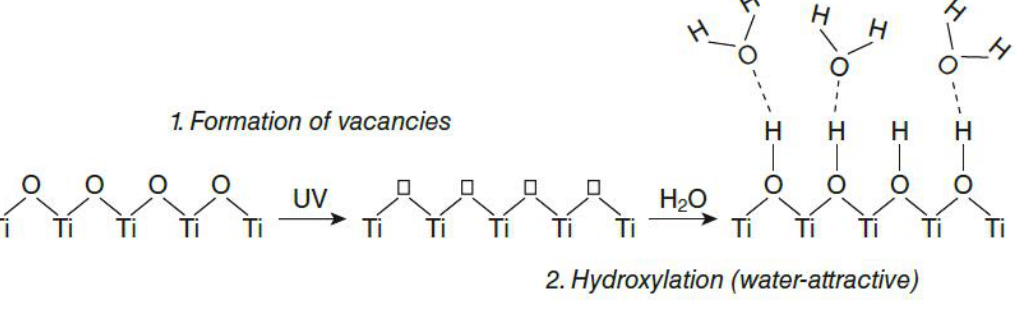
Figure 7. Self-cleaning approaches in materials.